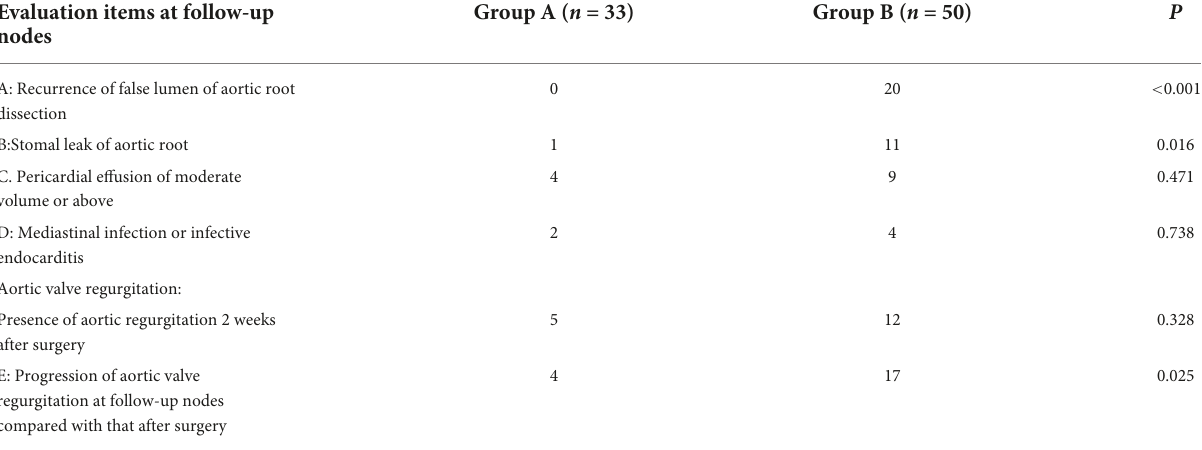
TABLE 3 Reoperation-related events.